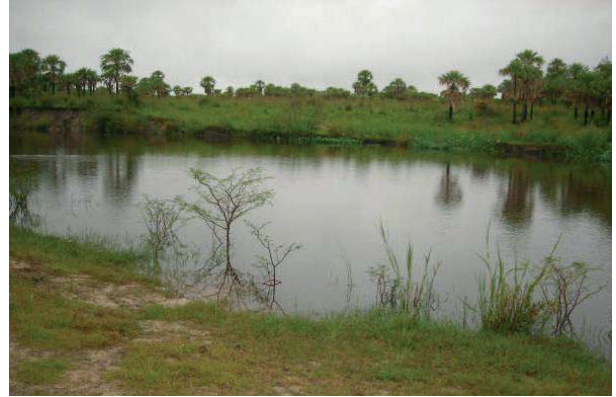
Fig. 4. Arroyo Yacaré, Mburika, Ñeembucú, Paraguay, type locality of Microglanis carlae